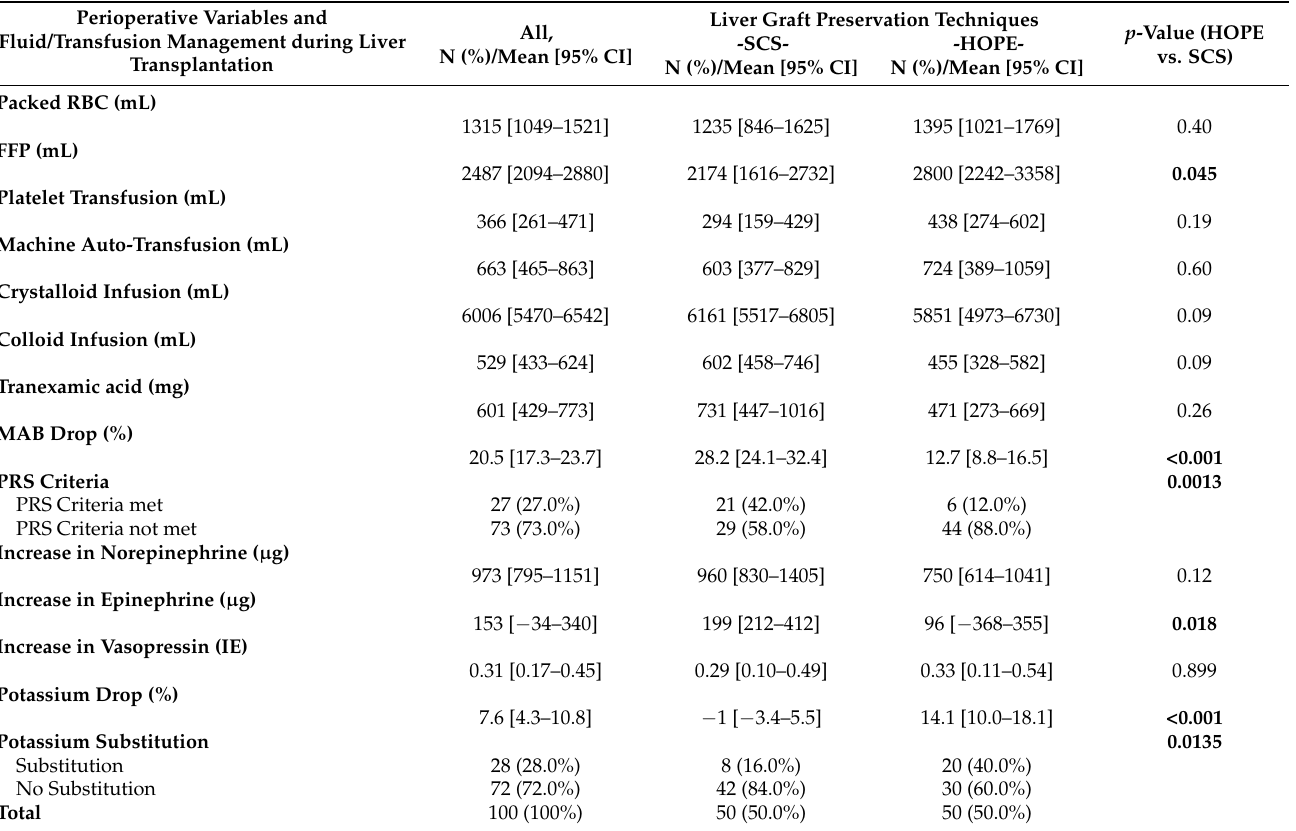
Table 3. Description of perioperative hemodynamic variables and fluid/transfusion management during liver transplantation, stratified by the liver graft preservation